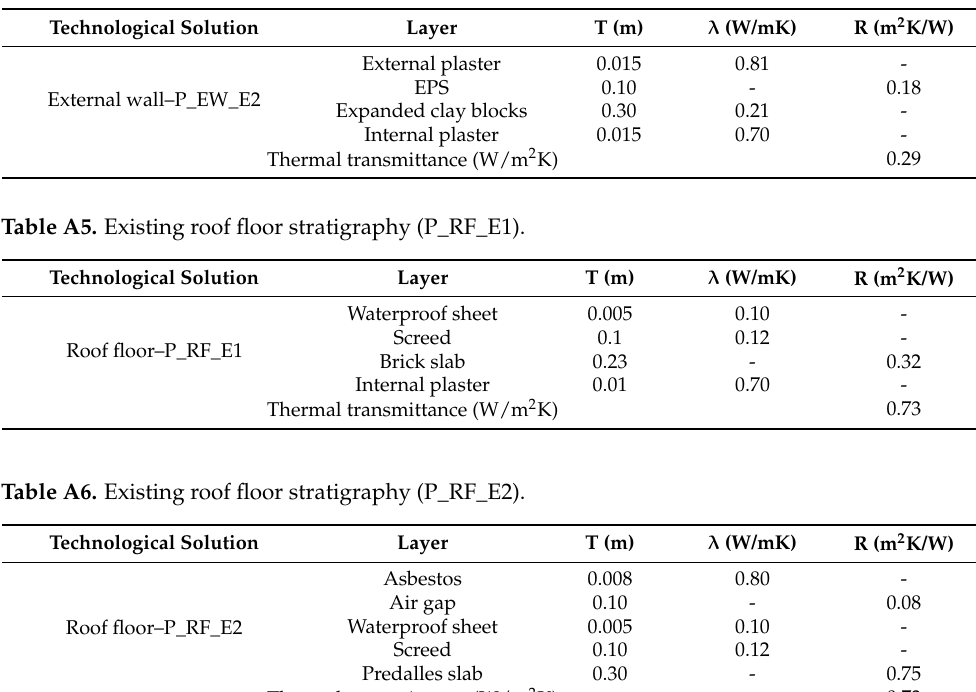
Table A4. Existing external wall stratigraphy (P_EW_E2) for the retrofitted block.